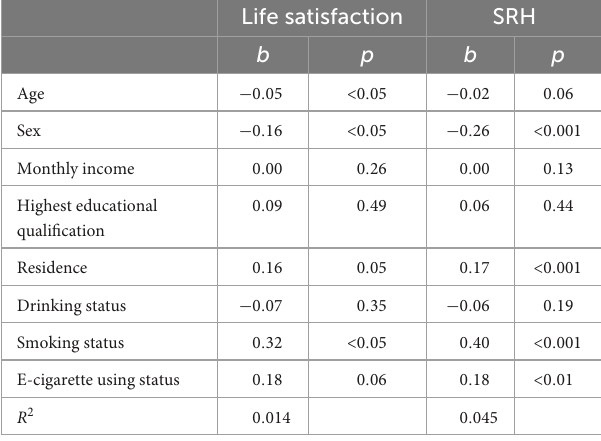
use illegal drugs the past